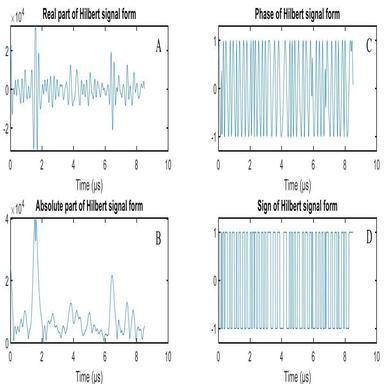
Signal processing from the Hilbert complex form of an A-Scan: A) Real part used for TFM reconstruction; B) Envelope extracted from the absolute part of the Hilbert transformed signal; C) Phase of the Hilbert transformed signal and, D) Sign of the Real part of the Hilbert transformed signal.